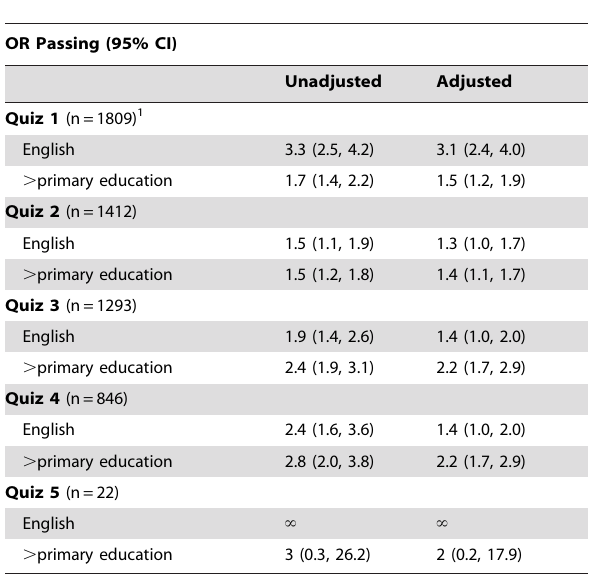
Table 5. Unadjusted and adjusted odds of passing quizzes 1– 5 by language and